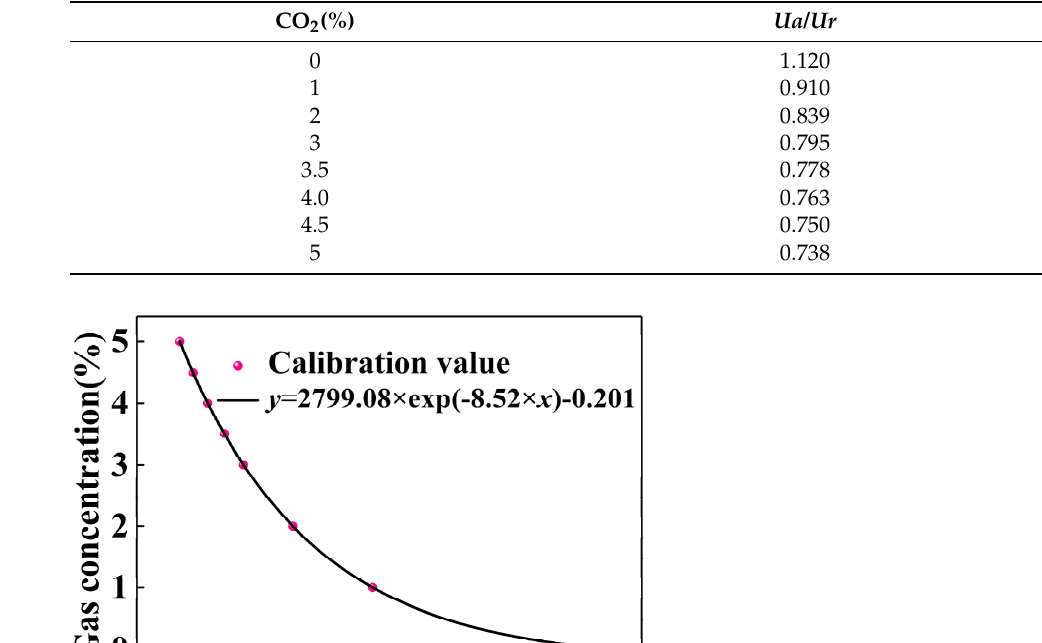
2 concentrations.